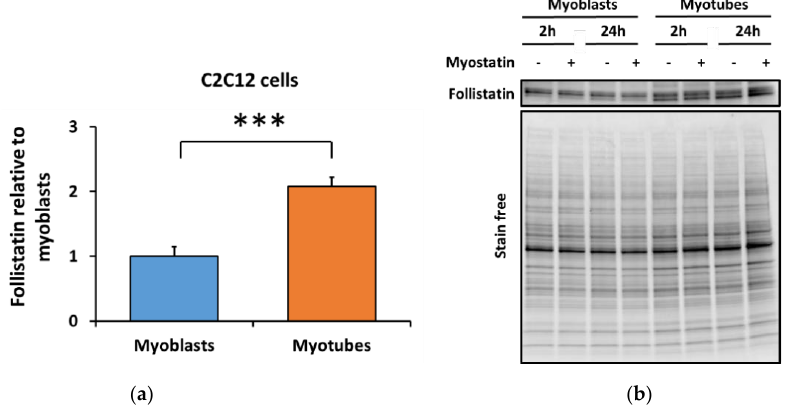
Figure 6. Differentiation of the C2C12 myoblasts into myotubes increased ( a ) follistatin protein content. In the figure, the values are presented as normalized to myoblasts = 1. ( b ) Representative blot. N = 12 per group as control (-) and myostatin (+) samples were pooled due to lack of myostatin effect. *** = P < 0.001.